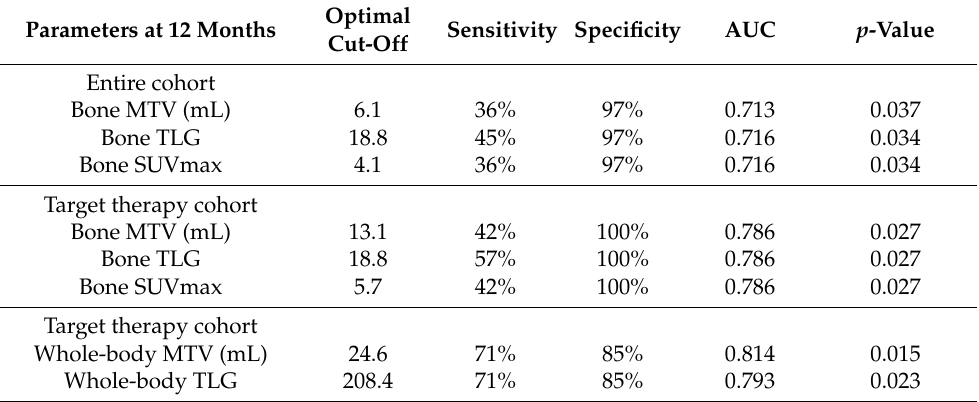
Table 2. Optimal cut-offs of semi-quantitative parameters associated with responder vs. non- responder patients at 12 months defined using the receiver operating characteristic (ROC) curve. Optimal Sensitivity Specificity AUC p -Value Parameters at 12 Months Cut-Off Entire